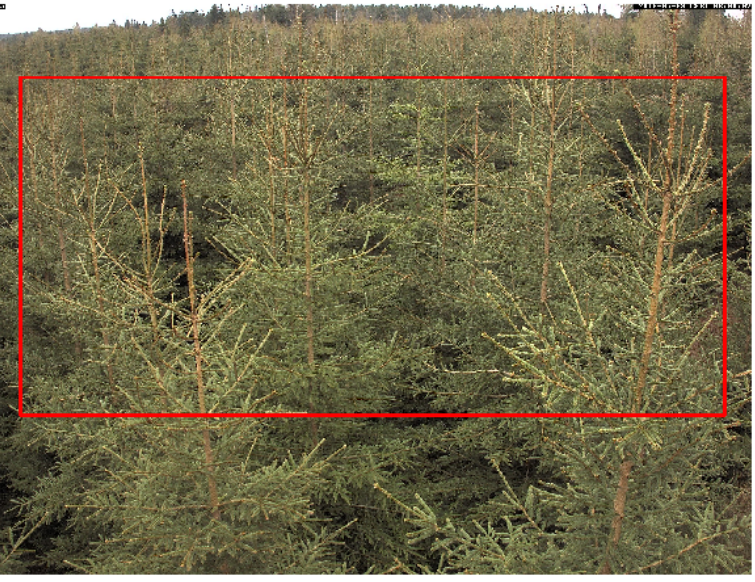
Figure 4. ROI (red rectangle) for extracting time series of RGB DN. (Image Source: SITES Spectral). The DN values distributed across all the pixels in the corresponding ROI were ex- tracted with a python code (involves use of OpenCV and NumPy module) that extracted the mean DN values of RGB bands across the defined ROIs. Then, the extracted mean DN values were fed into Equations (1) and (2) to compute GCC and VIgreen, respectively.